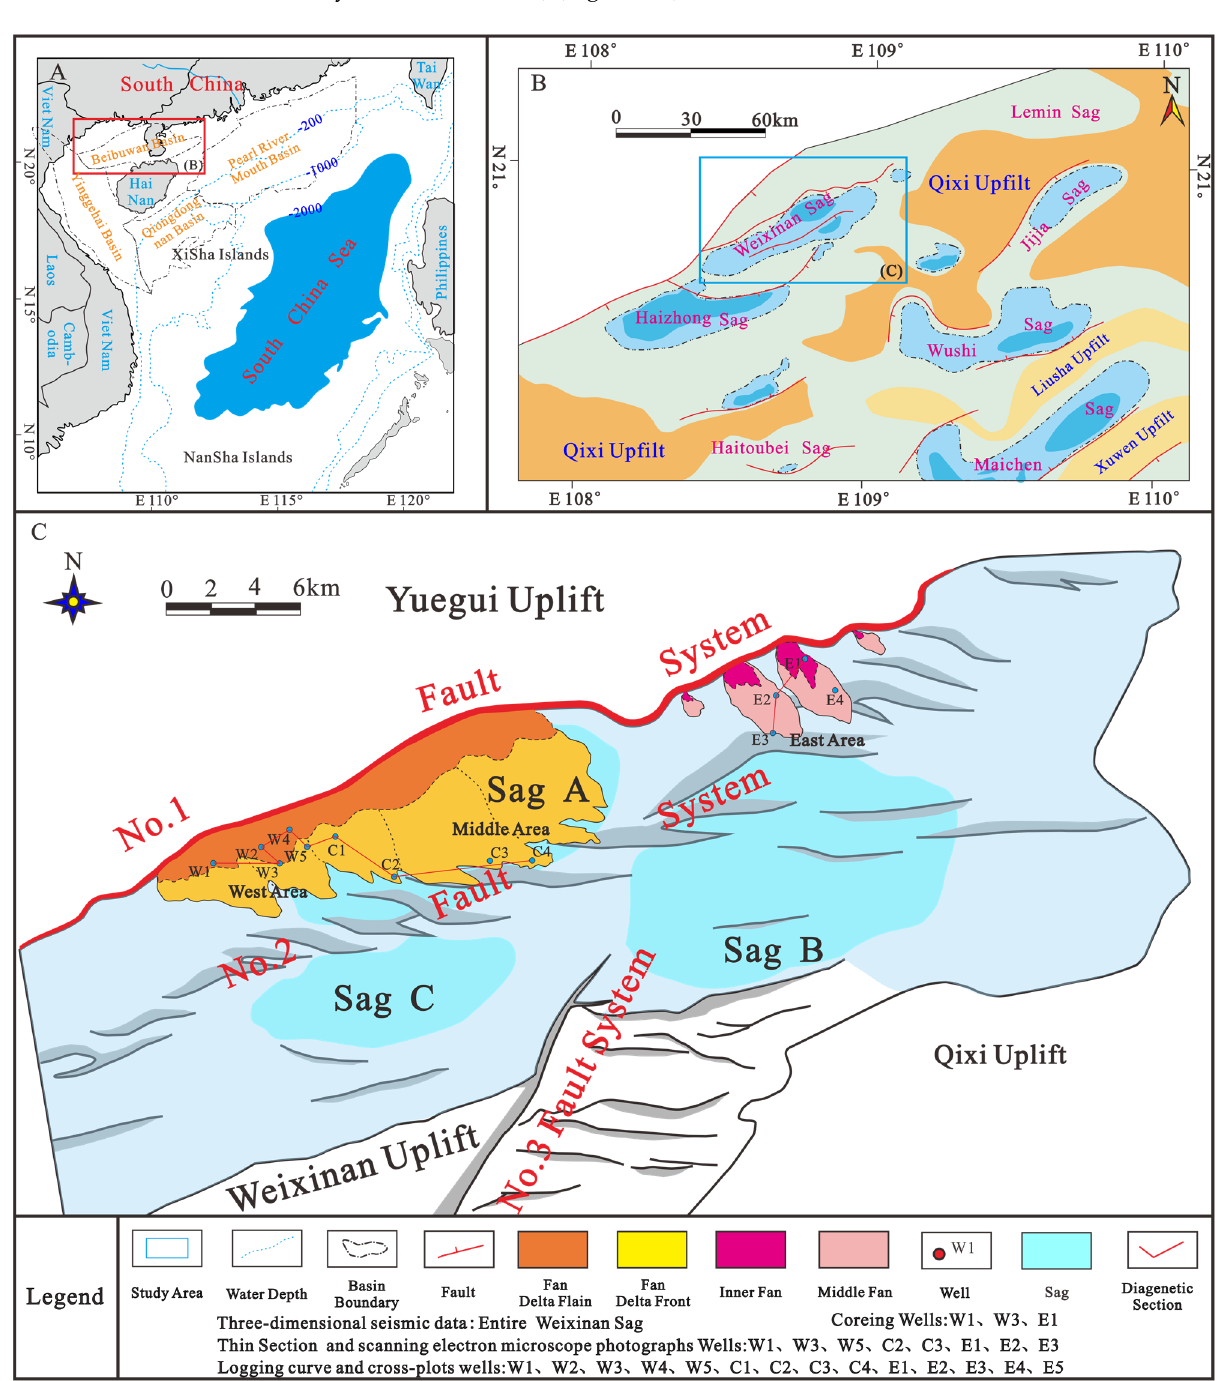
Figure 1. ( A ). Location map of sedimentary basins in the south China Sea. ( B ). Location map of the Weixinan Sag and other sags in the Beibuwan Basin. The Beibuwan Basin is shown in ( A ). ( C ). The division of the specific depositional system of the Liushagang Formation in the northern steep-slope zone in the Weixinan Sag. The Weixinan Sag is shown in ( B ).